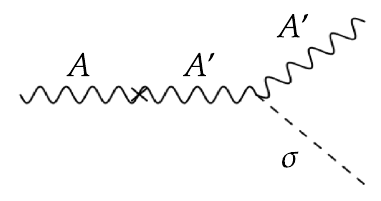
Figure 4 . The ‘Higgs-strahlung’ process for the Stückelberg photon. In this case, the emitted scalar particle is σ , the radial mode required by the radial mode conjecture (see section 3.2). The amplitude for this process is proportional to the product (cid:15)αg 0 where the first factor comes from the kinetic mixing and the second from the vertex (see eq. (3.15) for the definition of α